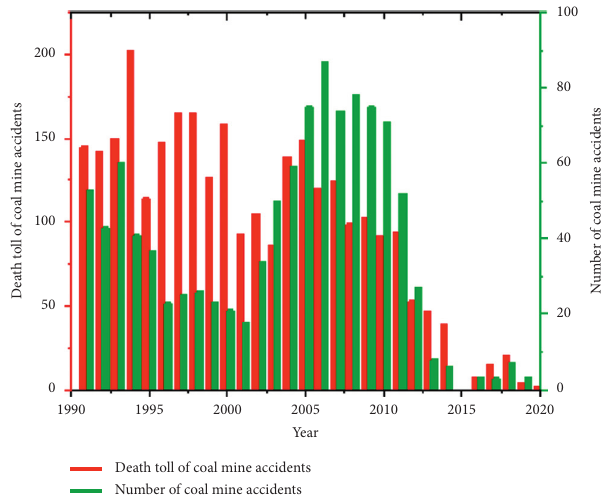
Figure 2: Number and death toll of coal mine accidents in LPS for